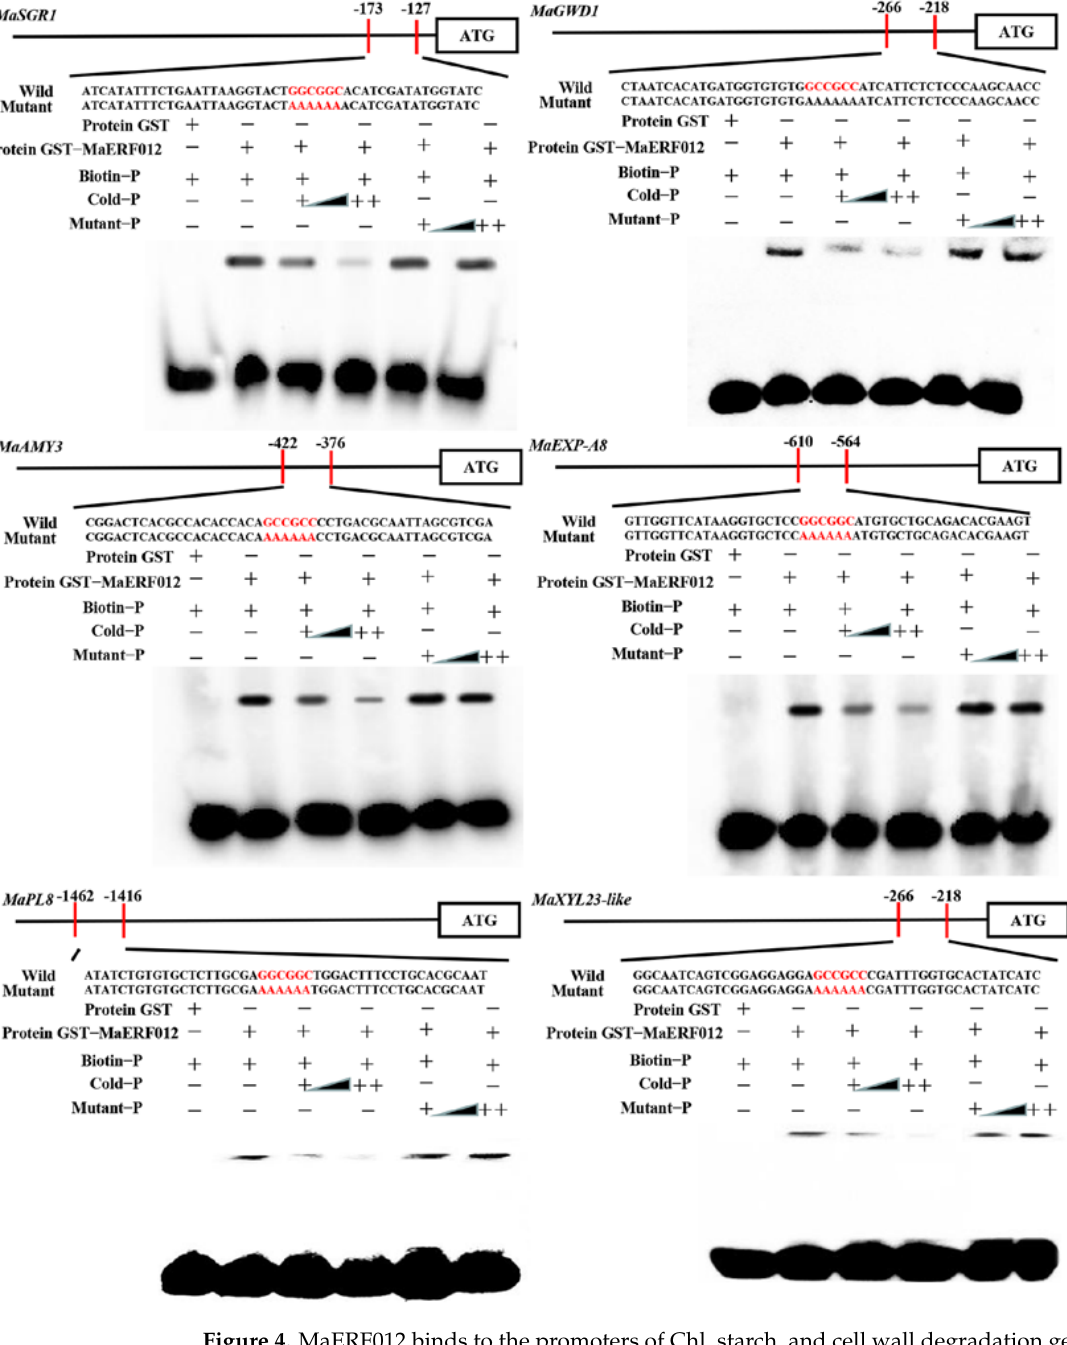
Figure 4. MaERF012 binds to the promoters of Chl, starch, and cell wall degradation genes in vitro. The interaction of MaERF012 and the promoter of MaSGR1 , MaGWD1 , MaAMY3 , MaEXP-A8 , MaPL8, and MaXYL23-like was verified using an EMSA. GST-MaERF012 was mixed with the probes for MaSGR1 , MaGWD1 , MaAMY3 , MaEXP-A8 , MaPL8, and MaXYL23-like promoters including the GCC-box motifs and the mutant probe AAAAAA, which is shown with red letters. ‘ − ’ represents absence; ‘+’ represents presence; ‘++’ indicates increasing amounts of unlabeled or mutated probes for competition.